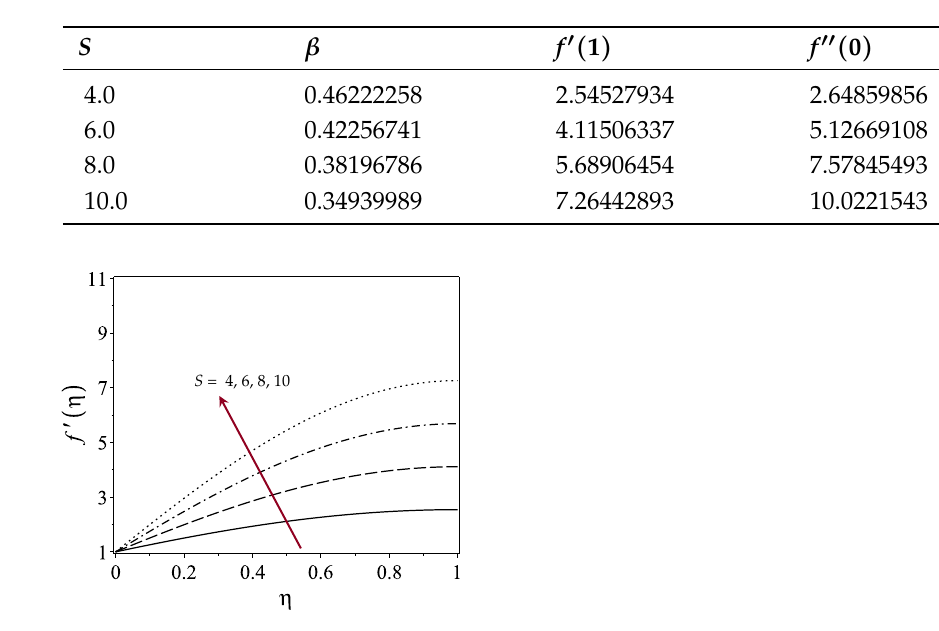
Figure 2. Velocity distribution f (cid:48) ( η ) variation with unsteadiness parameter S .